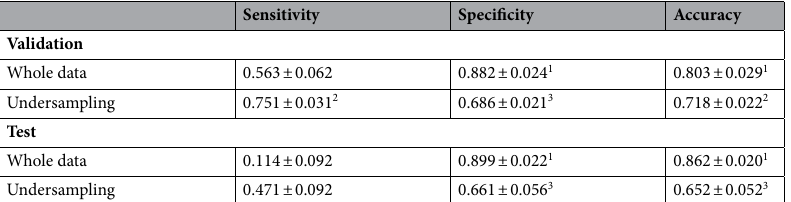
Table 6. Sensitivity, specificity and accuracy in split verification data and test data by learned RNN. Sensitivity, specificity and accuracy were calculated for RNN predictions and PCR results from 5 split validation groups for the whole data and undersampling sets respectively. For the Test data, the mean value and standard deviation were calculated for the results of prediction by the RNN that independently learned with each verification group. Numbers on superscript show groups in which no significant difference are detected. On the other combinations, significant differences were shown with the Student’s and Welch’s